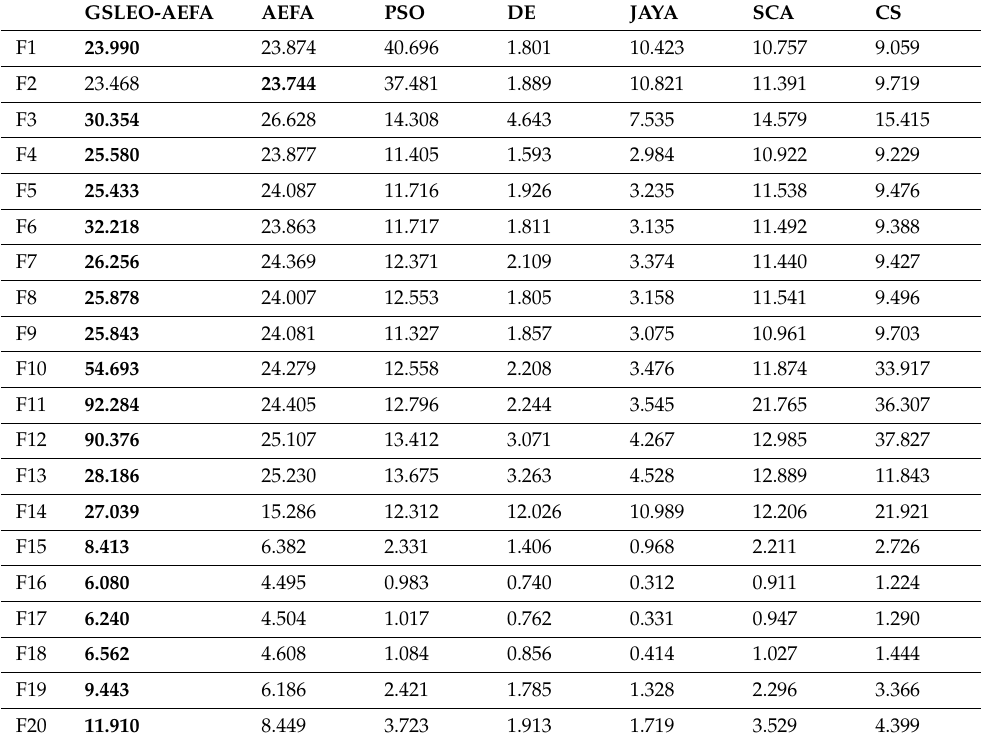
Figure 5. Diversity plots for GSLEO-AEFA and AEFA for the unimodal functions F1, F2 and the multimodal functions F10, F12. Table 8. Computational time comparison, high values are in